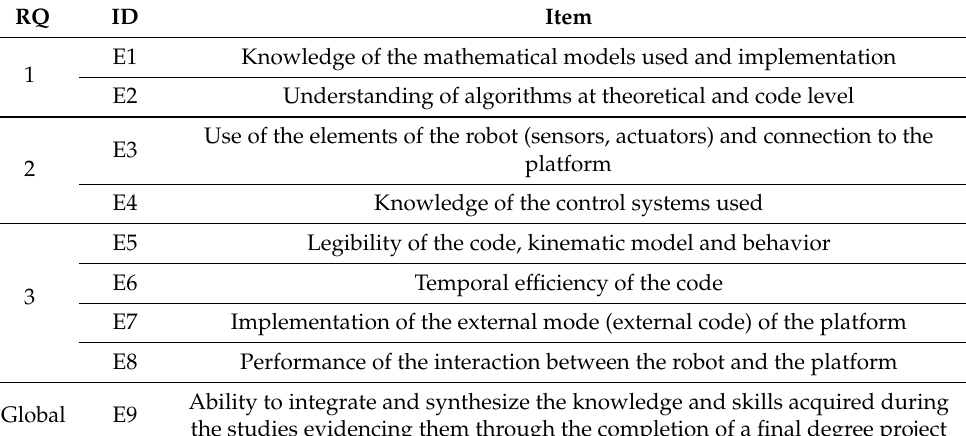
Table 2. Evaluation questions for the Type A projects associated to the research